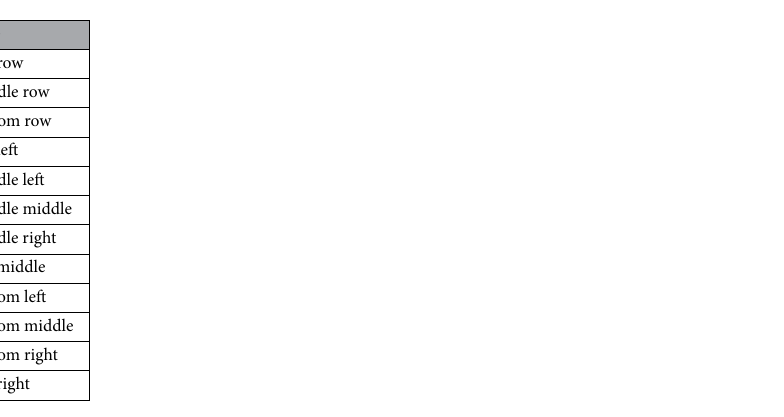
Table 1. Combinations of vaccine actions examined in this study. In columns, various vaccine actions are indicated: protection against infection (I), symptoms appearance (S), hospital admission (H), need of ICU (U), and death